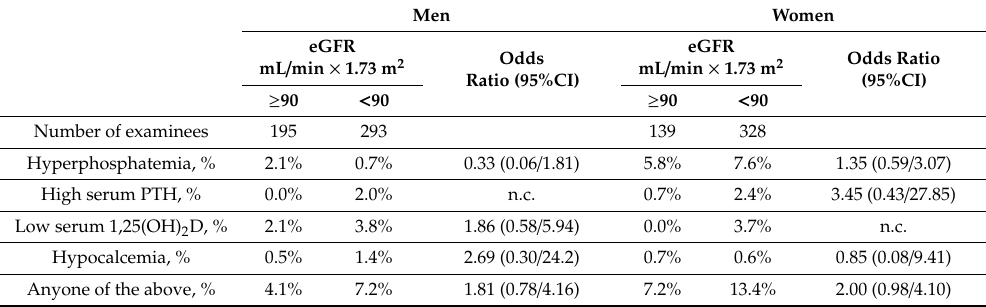
Table 2. Moli-sani study dataset: prevalence of hyperphosphatemia, of high serum PTH, of low serum 1,25(OH) 2 D, of hypocalcemia, and of individuals with at least one of the CKD-MBD metabolic abnormalities in the group without reduced kidney function compared to the group with reduced kidney function (eGFR ≥ 90 and < 90 mL / min × 1.73 m 2 , respectively). Men